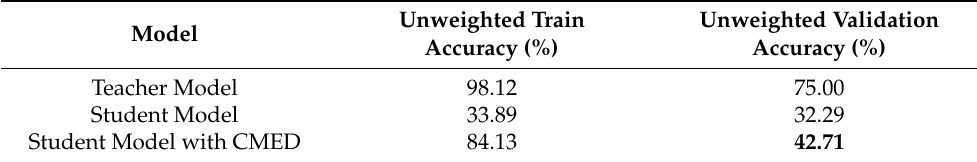
Table 6. Results of the experiments on EMO-DB.